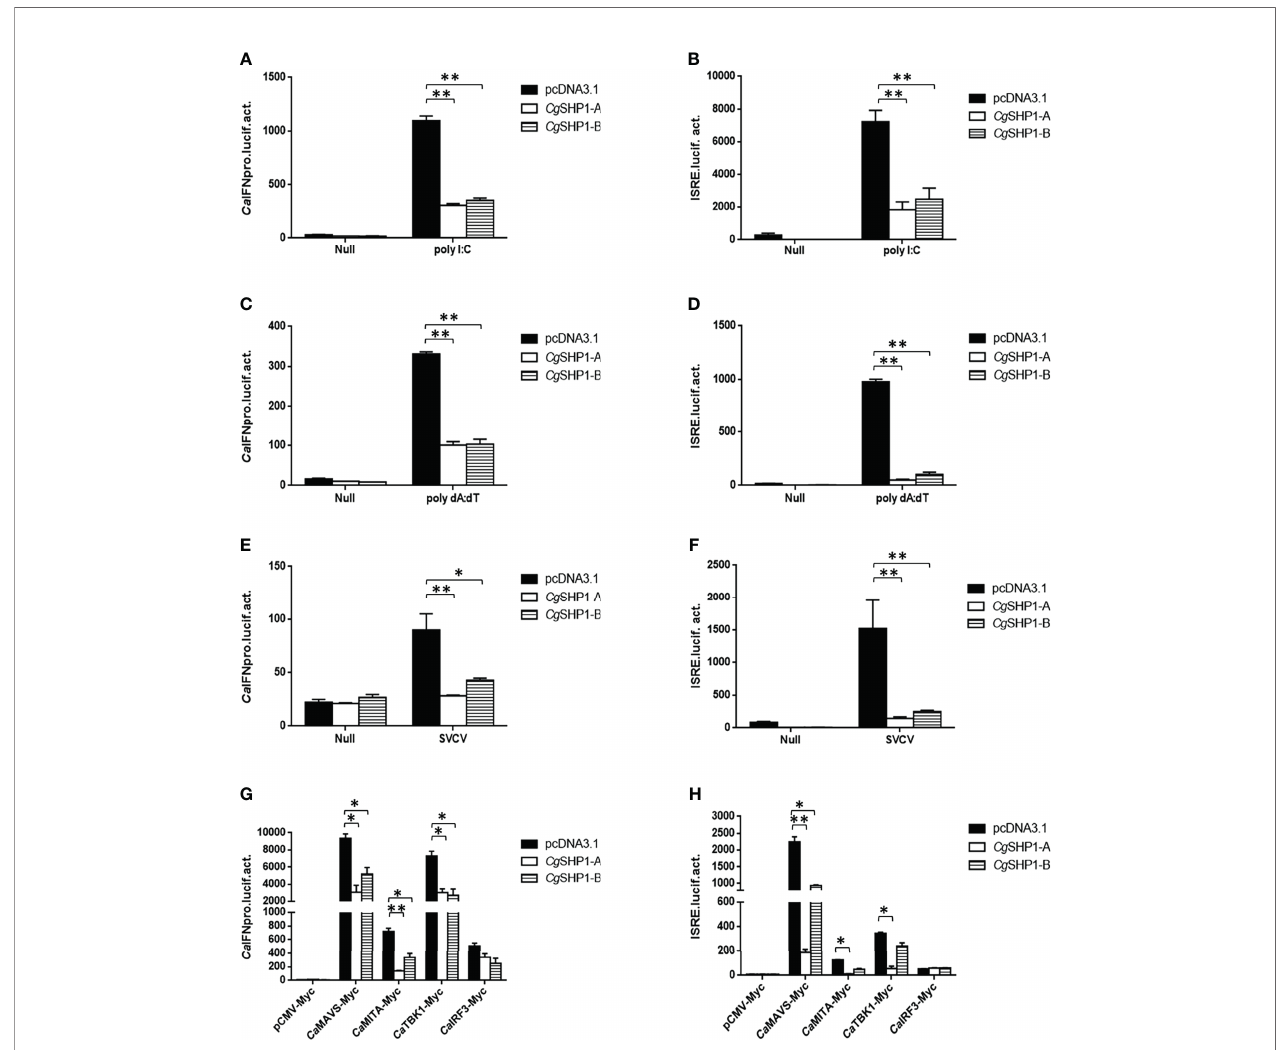
FIGURE 4 | Cg SHP1-A and Cg SHP1-B inhibit IFN response induced by 1 m g poly I:C (A, B) , poly dA:dT (C, D) , SVCV (MOI = 1) (E, F) in EPC cells. Cg SHP1-A and Cg SHP1-B inhibit Ca MAVS, Ca MITA and Ca TBK1-mediated activation of Ca IFNpro and ISRE (G, H) . Data are expressed as mean ± SEM, n = 3. Asterisks indicate signi fi cant differences from control (* p < 0.05, ** p <